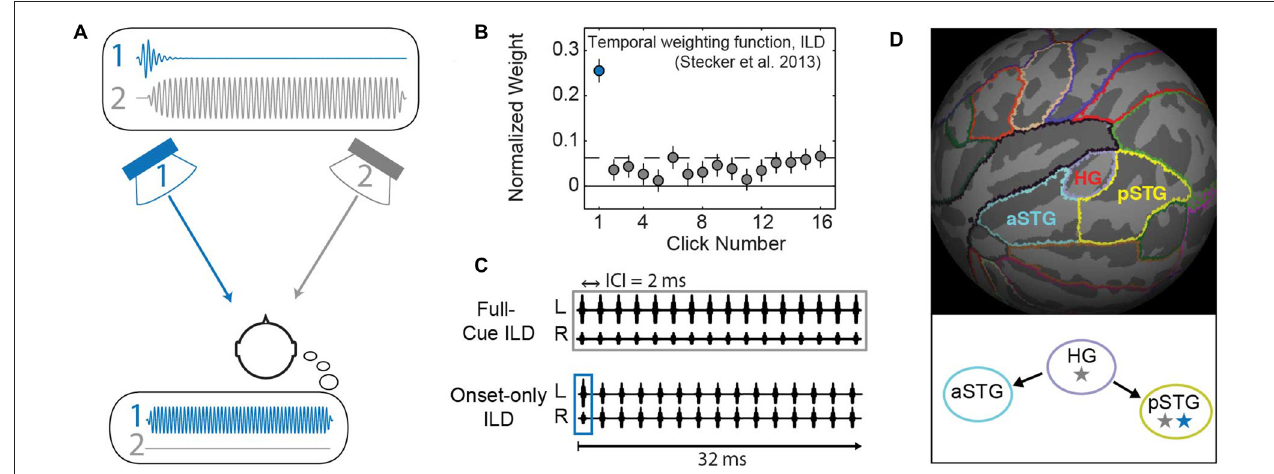
FIGURE 1 | Background and methods. (A) In the Franssen effect, a tone is briefly presented from one loudspeaker (1, blue), and quickly cross-faded to a second loudspeaker (2, gray). Although only loudspeaker 2 sounds during most of the tone’s duration (upper inset plots physical waveform), listeners erroneously perceive the sound to emanate from the loudspeaker that presented the onset (i.e., speaker 1; lower inset illustrates the resulting percept). This type of effect can be quantified by measuring a “temporal weighting function” that plots the perceptual “weight” which listeners apply to each part of the sound duration (Stecker et al., 2013). (B) The temporal weighting function for interaural level differences (ILD) carried by a train of 16 clicks repeating at 2 ms ICI reveals largest weight on the first click (blue), consistent with onset dominance as seen in the Franssen effect. (C) Click-train stimuli modified from Stecker et al. (2013) were used in the current study. Upper: in the full-cue condition, all 16 clicks carry the same ILD value. Lower: the onset-only condition tests ILD carried only by the first click; other clicks carry zero ILD, thus providing a simulation of the Franssen effect over headphones. (D) Regions of interest (ROIs) were defined on the average cortical surface (FSaverage). Colors indicate boundaries of Heschl’s gyrus (HG), anterior superior temporal gyrus (aSTG) and posterior superior temporal gyrus (pSTG) relative to cortical gyri (light gray) and sulci (dark gray). Lower panel illustrates “dual-stream” theories of primate auditory cortex (AC; Rauschecker and Scott, 2009): AC core regions (HG) exhibit sensitivity to stimulus features including binaural cues (gray star). Information propagates from core to anterior regions (aSTG) that lack spatial sensitivity (no star) and to posterior regions (pSTG) that maintain sensitivity to binaural/spatial cues (gray star) and are implicated in the perceptual processing of auditory space (blue